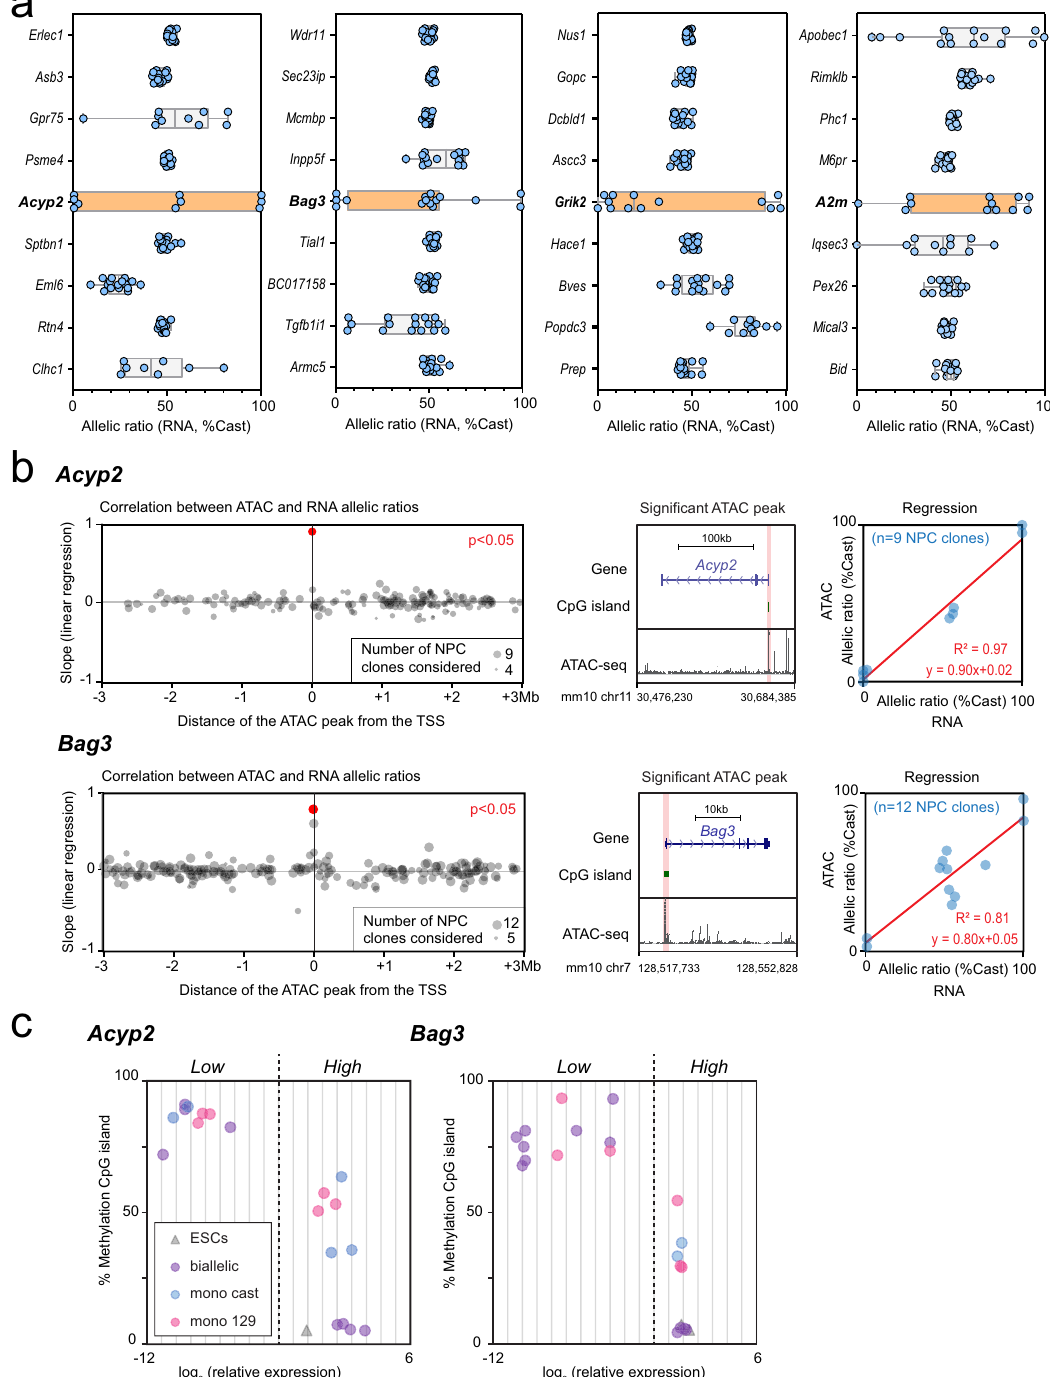
Fig. 7 Allelic imbalance is regulated locally. a Comparison of the distribution of allelic expression ratios for Acyp2 , Bag3 , Grik2 and A2m , with four upstream and four downstream neighbouring genes, measured by allele-speci fi c RNA-seq in 16 NPC clones. Boxplot elements: centre line represents the median, box bounds represent the 25th and 75th percentiles, whiskers represent the minimum and maximum. The orange colour highlights the boxplot plot of the RME gene of interest. b Identi fi cation of the genomic region where allele-speci fi c accessibility correlates best with expression, by linear regression between the ATAC-seq allelic accessibility ratio and RNA-seq allelic expression ratio, for ATAC-seq peaks (containing at least one SNP) within a region of ±3 megabases around the TSS. P value adjusted with Bonferroni correction, number of ATAC peaks: 177/207 Acyp2 / Bag3 (left panels). UCSC genome browser snapshot showing a representative ATAC-seq track along the gene, with highlighting of the ATAC-seq peak, located at the TSS, that correlates signi fi cantly with the RNA-seq (middle panels). Linear regression showing the correlation between the ATAC-seq allelic accessibility ratio and the RNA-seq allelic expression ratio at the TSS (right panels). ATAC-seq data and RNA-seq datasets are from 13 NPC clones. Acyp2 F (1,7) = 227, p = 1.3 × 10 − 6 ; Bag3 F (1,9) = 42, p = 7.3 × 10 − 5 . c DNA methylation levels over the CpG island located at the TSS of Acyp2 and Bag3 , measured by Sequenom bisul fi te analysis in 21 representative NPC clones and the two ES cell lines, characterised by high or low expression levels and mono- or biallelic